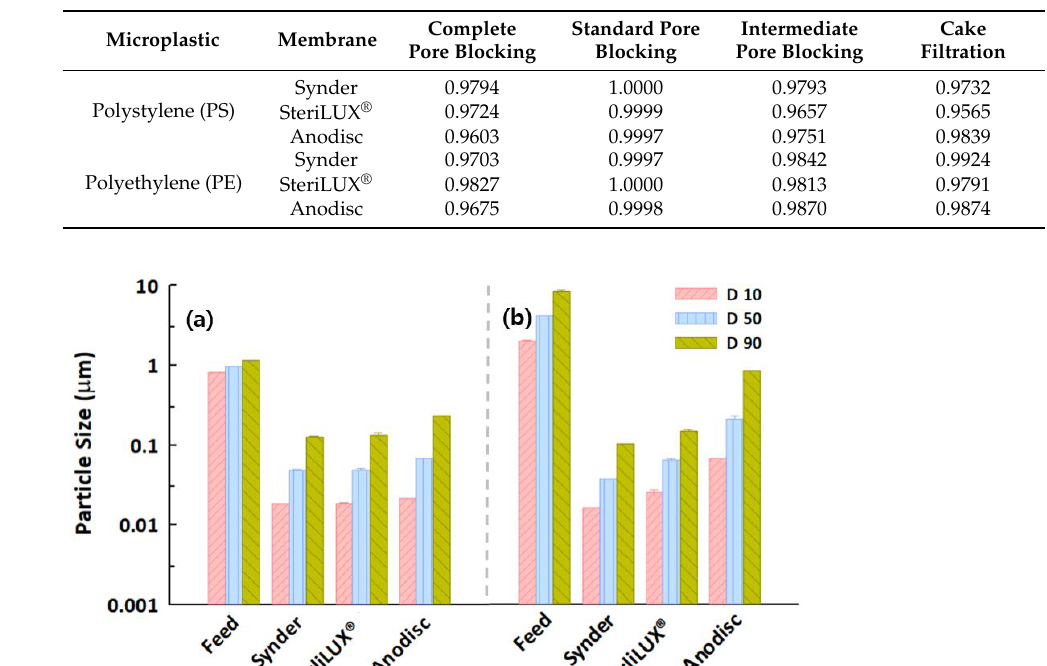
Figure 6. Normalized water flux decline of 1.0 μm PS and PE microplastics for ( a ) Synder, ( b ) SteriLUX ® , and ( c ) Anodisc membranes. Table 4. R 2 values corresponding to the fouling mechanisms estimated by the blocking model for 1.0 μm PS and PE microplastics during the three different membrane filtrations.